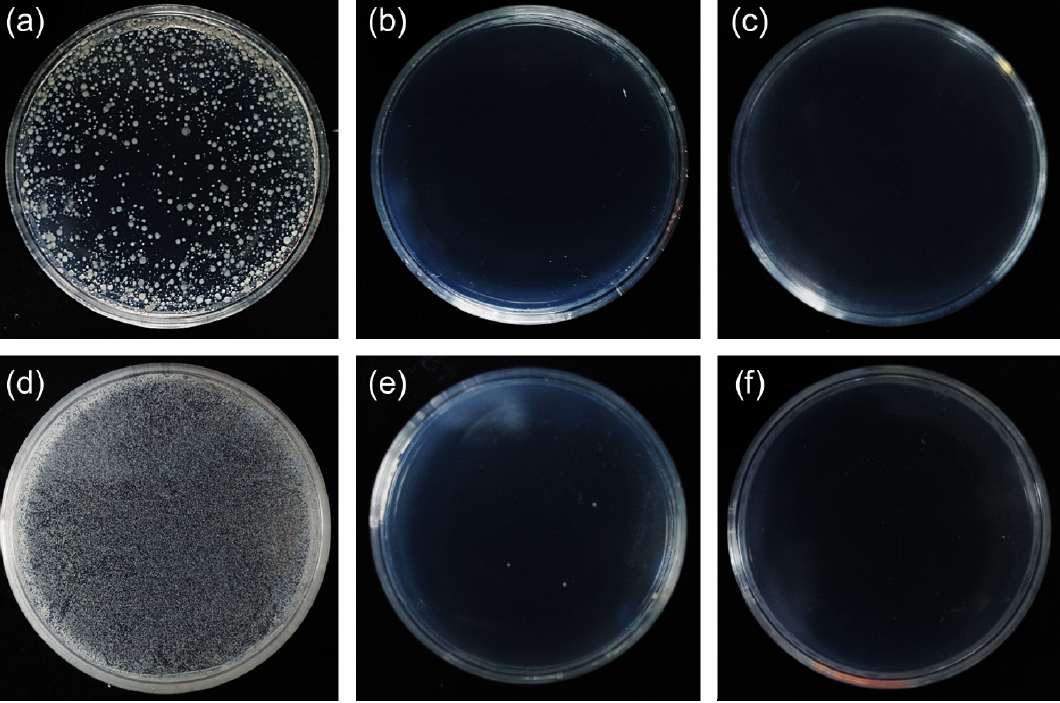
Figure 5. ( a ‒ c ) The antibacterial activity against E. Coli by pure carbon fiber fabrics ( a ); Te NW-based carbon fiber fabrics ( b ); and Te-Au 0.8 NW-based carbon fiber fabrics ( c ); ( d ‒ f ) The antibacterial activity against S. aureus by pure carbon fiber fabrics ( d ); Te NW-based carbon fiber fabrics ( e ); and Te-Au 0.8 NW-based carbon fiber fabrics ( f ). All the results were obtained based on AATCC 100 test method.